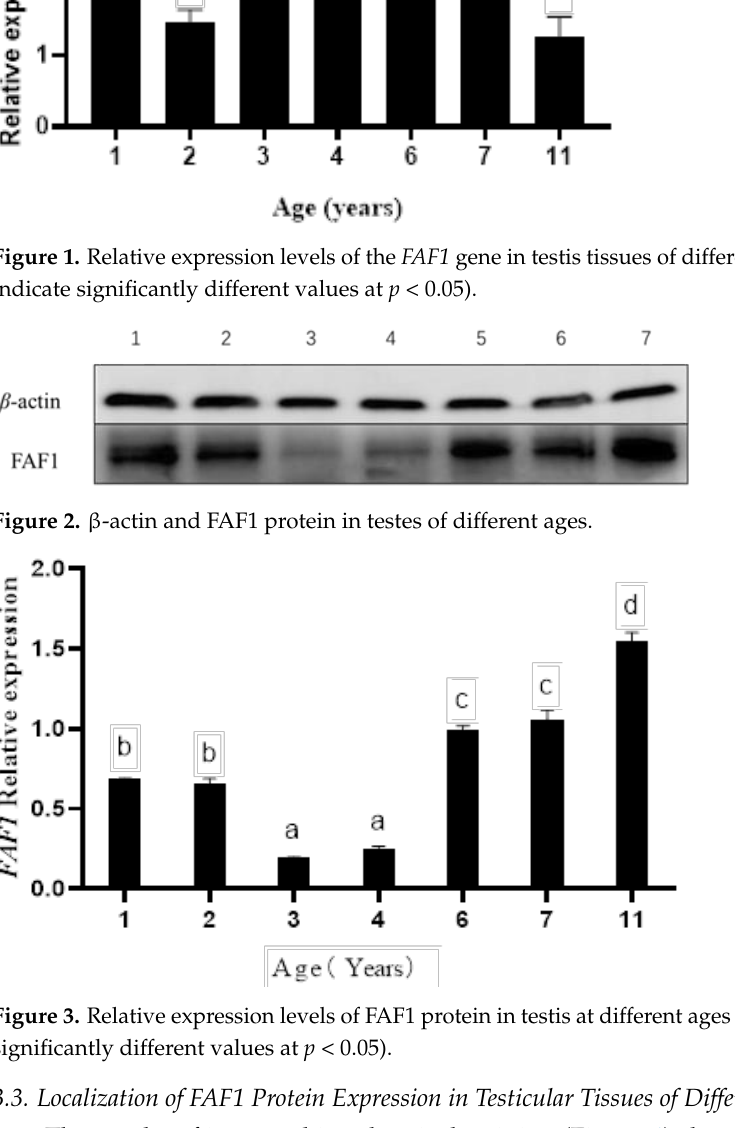
Figure 1. Relative expression levels of the FAF1 gene in testis tissues of different ages (different letters indicate significantly different values at p < 0.05).